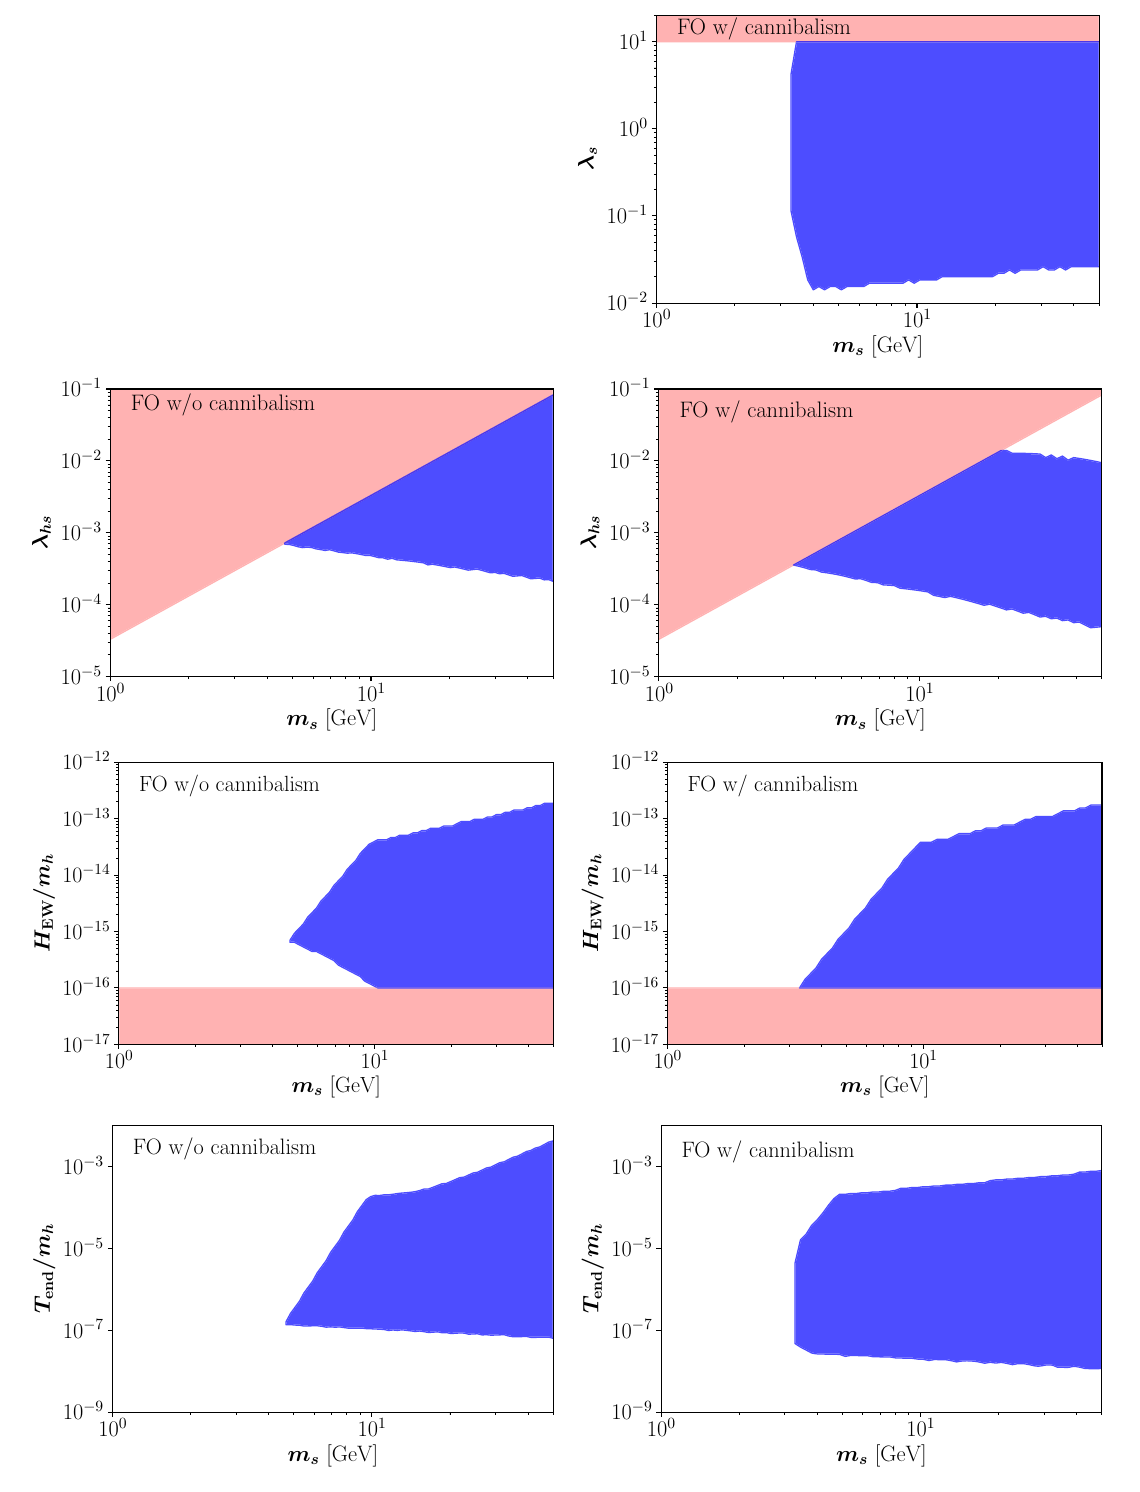
Fig. 4 DM freeze-out without (left column) and with (right column) cannibalism. Parameter space giving rise to the observed DM relic abundance. The red regions correspond to the constraints discussed in Sect. 2.2: the SM temperature after the matter-like component has decayed into SM particles must be larger than the BBN temperature